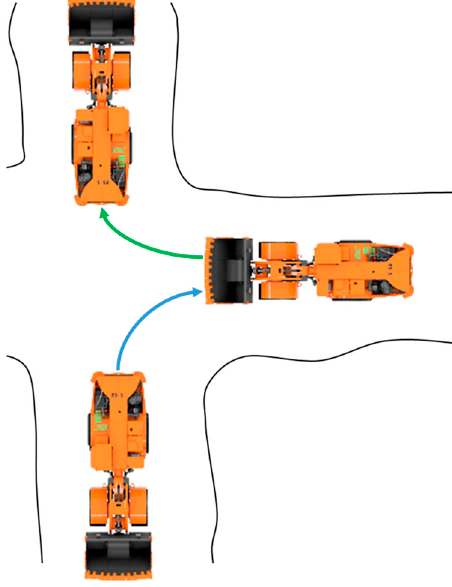
Figure 2. Example of inversion maneuver.